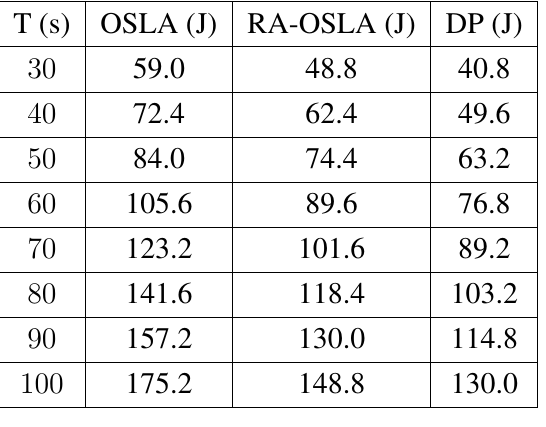
Table 2. Comparison of cumulative cost J different total time horizons.